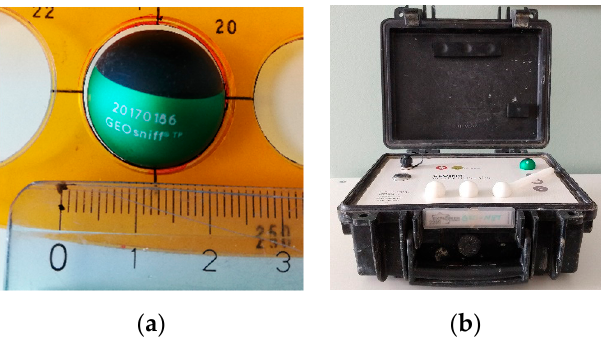
Figure 2. ( a ) Submersible sensor (ruler units are centimeters) and ( b ) its validation box.